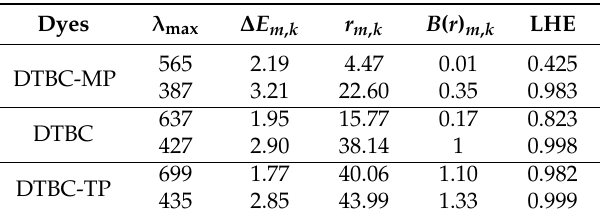
Table 1. The calculated light harvesting efficiencies (LHE), transition dipole moments ( r m , k , in a.u.) and relative absorption coefficients B ( r ) m , k of Q and B bands (the absorption peaks near 420 nm were called B bands , and the 500~750 nm range of absorptions were coded as Q bands) for DTBC-MP, DTBC and DTBC-TP dyes. The corresponding λ max (in nm) and excitation energies ∆ E m , k (in eV) are also listed. Dyes λ max ∆ E m , k r m , k B ( r ) m , k LHE 565 2.19 4.47 DTBC-MP